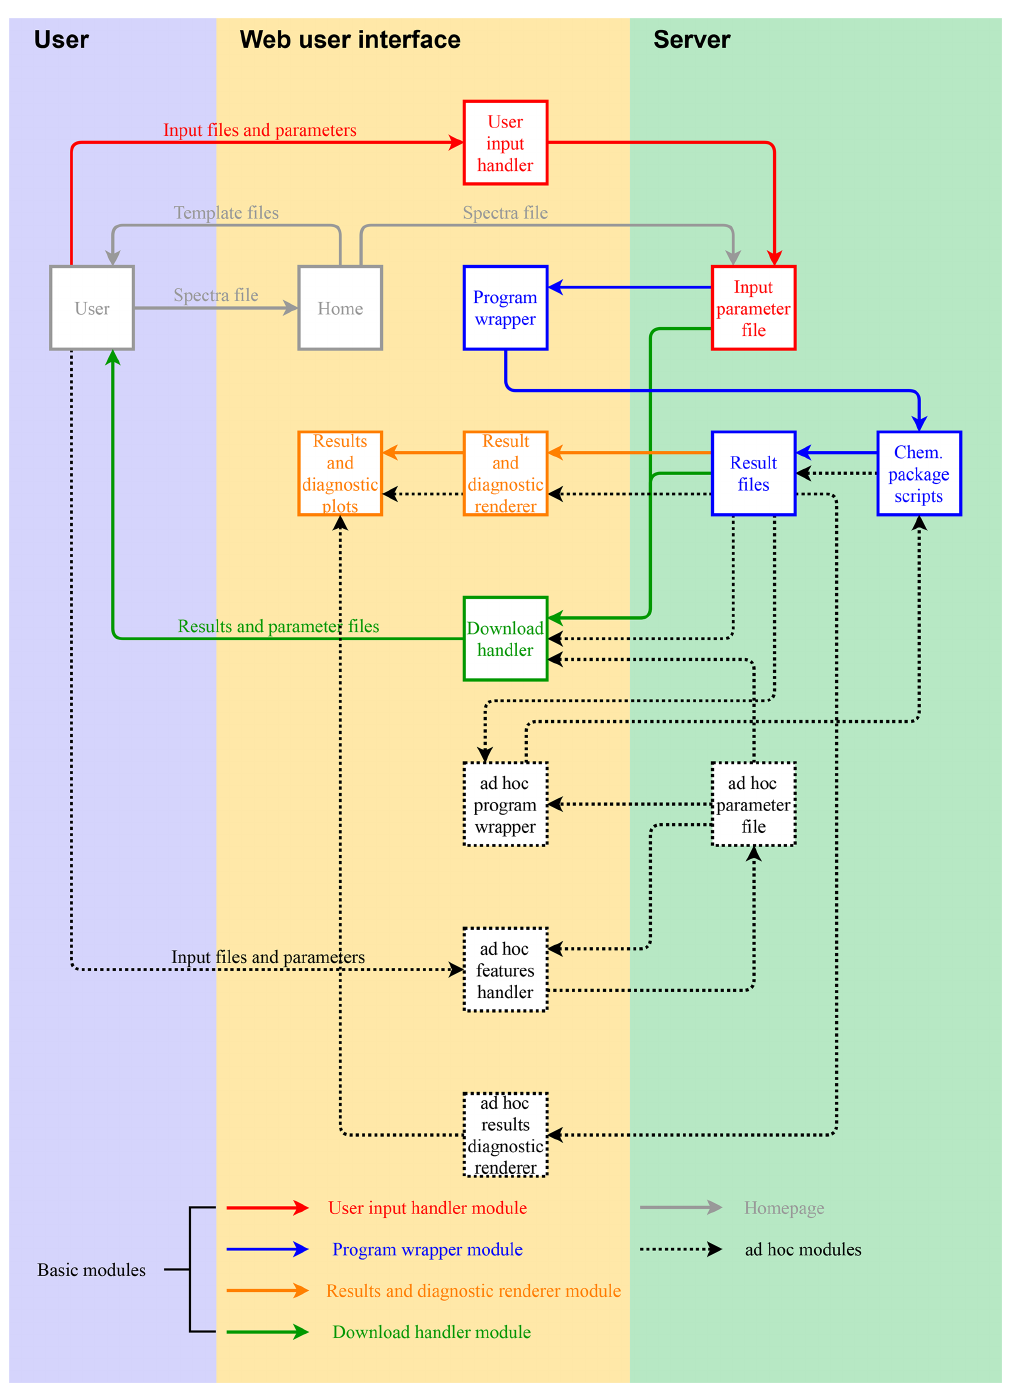
Figure 3. Chemometric package diagram and workflow. Solid boxes and arrows refer to Shiny modules used by each chemometric package (necessary modules). Supplementary features are handled by ad hoc modules and denoted by dotted boxes and arrows.